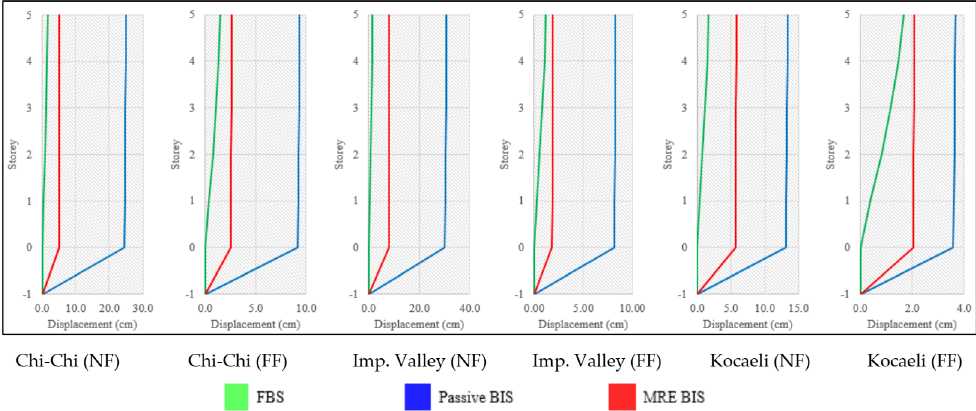
Figure 8. Storey-wise total displacements.